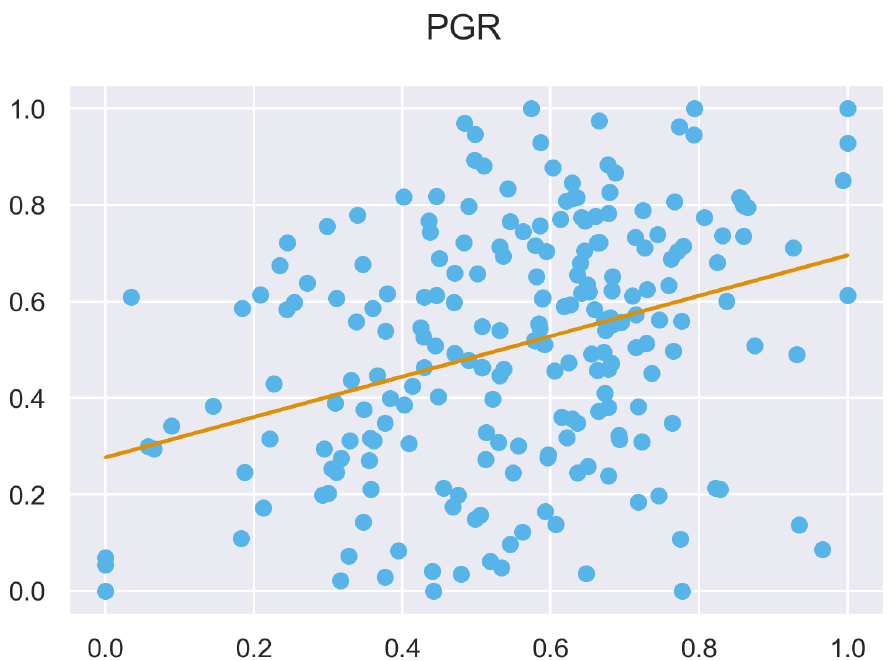
Figure A50. ULS and TLS PGR regression at 5m grid